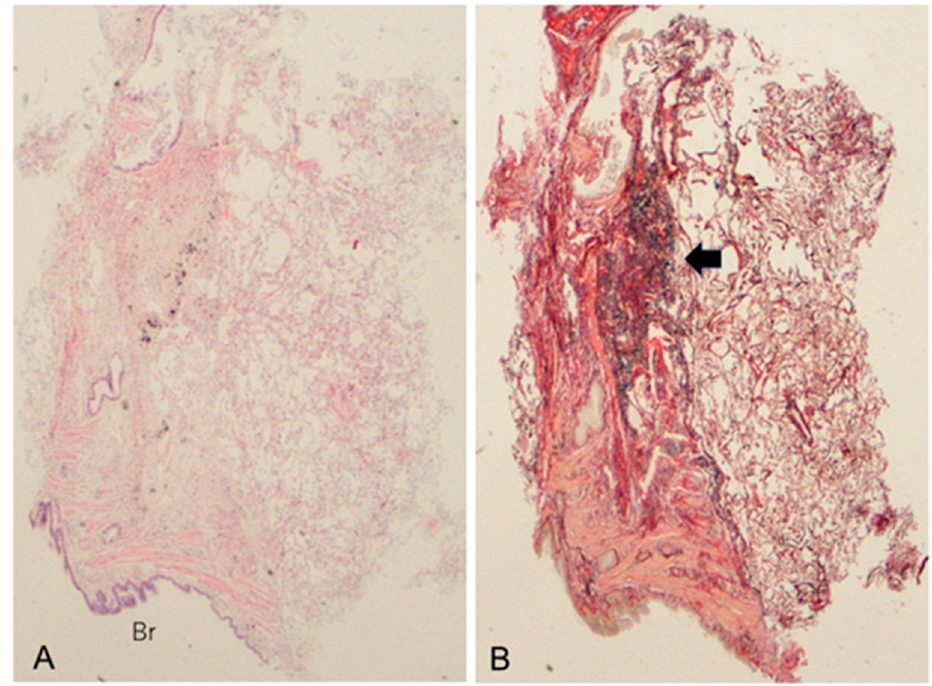
Figure 4. Pathological findings of the same patient with MPA-ILD shown in Figure 3. The transbronchial lung cryobiopsy specimens revealed the presence of dense fibrosis with elastosis apposed to a bronchus, located at the perilobular area (arrow), and an area of normal alveoli can be also seen, which makes up the framework of the UIP pattern (( A ): × 1; hematoxylin and eosin staining; Br, bronchus. ( B ): × 1; Elastica van Gieson staining).